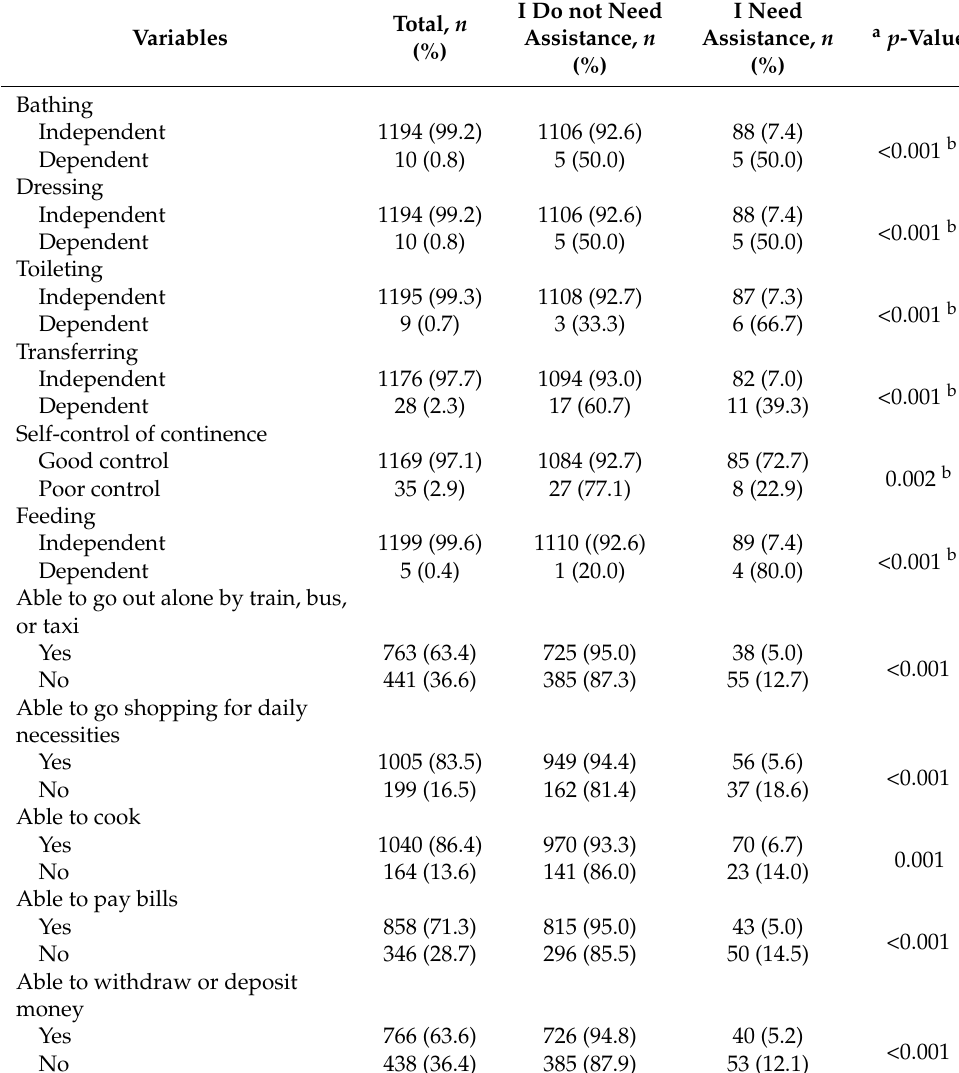
Table 2. Descriptive and bivariate analysis of activity of daily living (ADL), instrumental activity of daily living (IADL), mobility, and falls associated with the need for